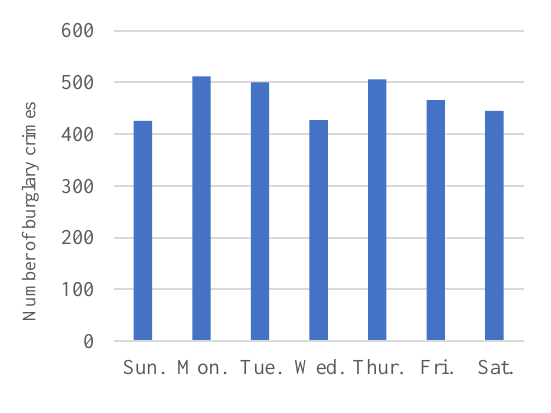
Figure 4. Overall burglary crimes by weekday